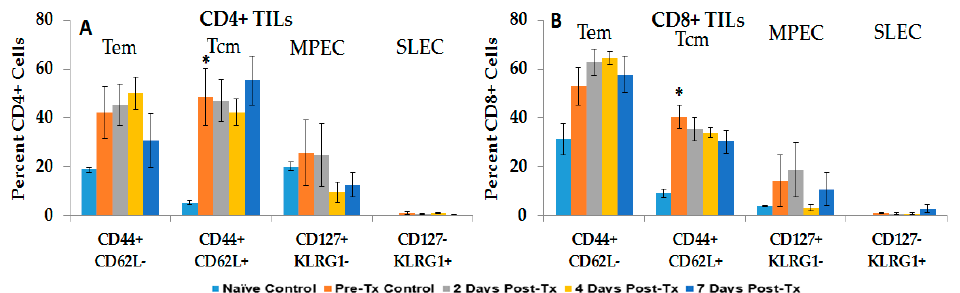
Figure 4. Tumor-infiltrating lymphocytes (TILs) change phenotypes in response to NPS in the liver. Lymphocytes were isolated from rat livers (tumor bearing lobe) at various times post-Tx. Cells were stained with CD4, CD8, CD44, CD62L, CD127 and KLRG1. Analyses were done on CD4+ cells ( A ) and CD8+ cells ( B ). Error bars = standard error of the mean (SEM); Naïve n = 4, Pre-Tx n = 5; others n = 6; * p < 0.05